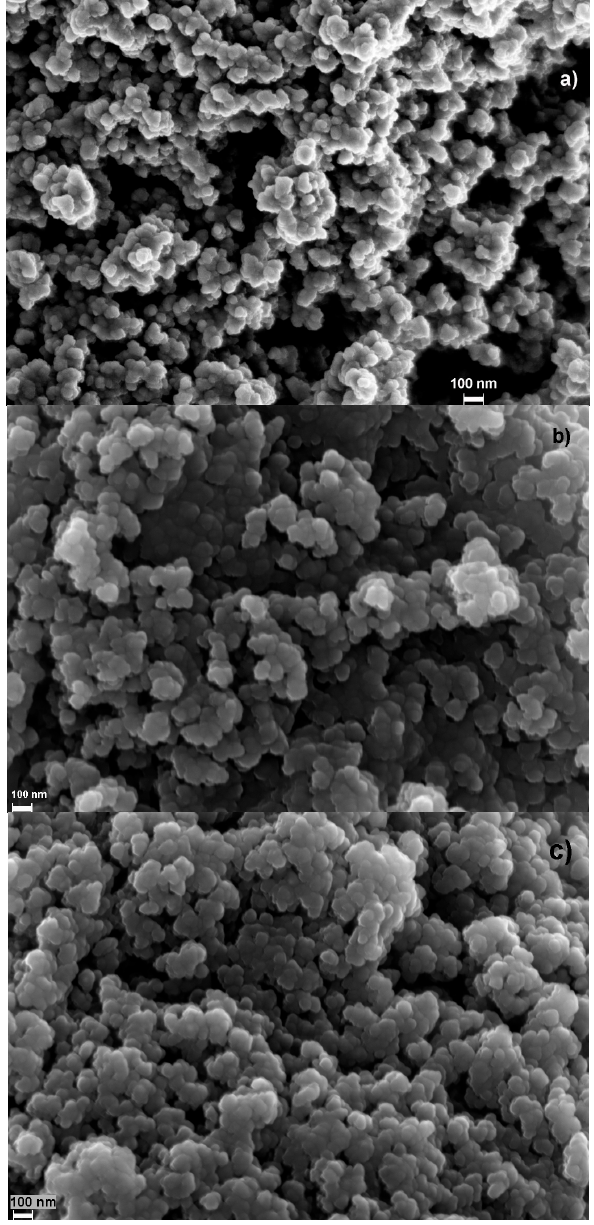
Figure 1. Scanning electron microscopy (SEM) microphotographs obtained at 100.00 KX of magnification: ( a ) XCo6; ( b ) XCo1; and ( c ) ACo6.